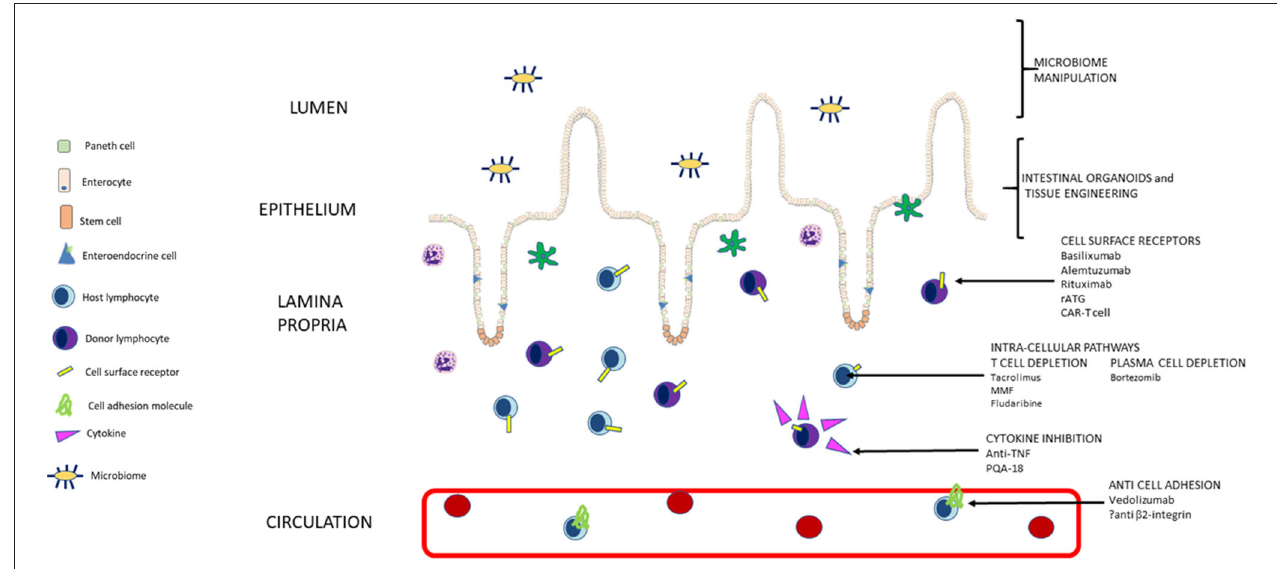
FIGURE 1 | Summary of pathways targeted by current and new approaches to immunosuppression in intestinal transplant (not to scale).